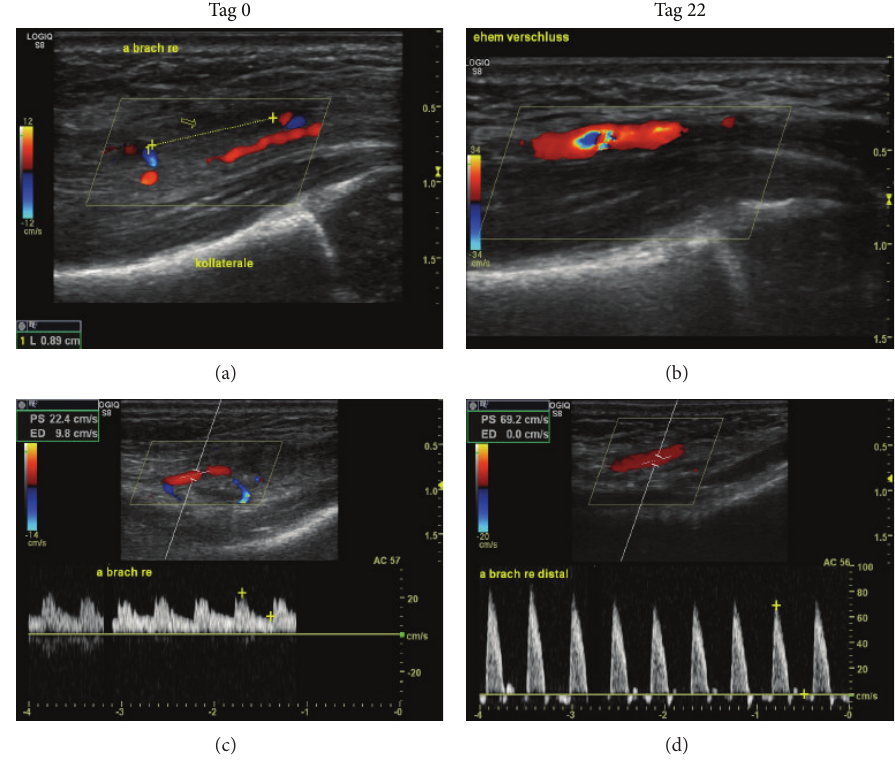
Figure 1: (a) Thrombosis of the right brachial artery at the time of diagnosis. (c) Corresponding severely diminished Doppler velocities distal to the site of occlusion (day 0). (b) Restored patency of the brachial artery (day 22). (d) Corresponding normalized Doppler pattern (day